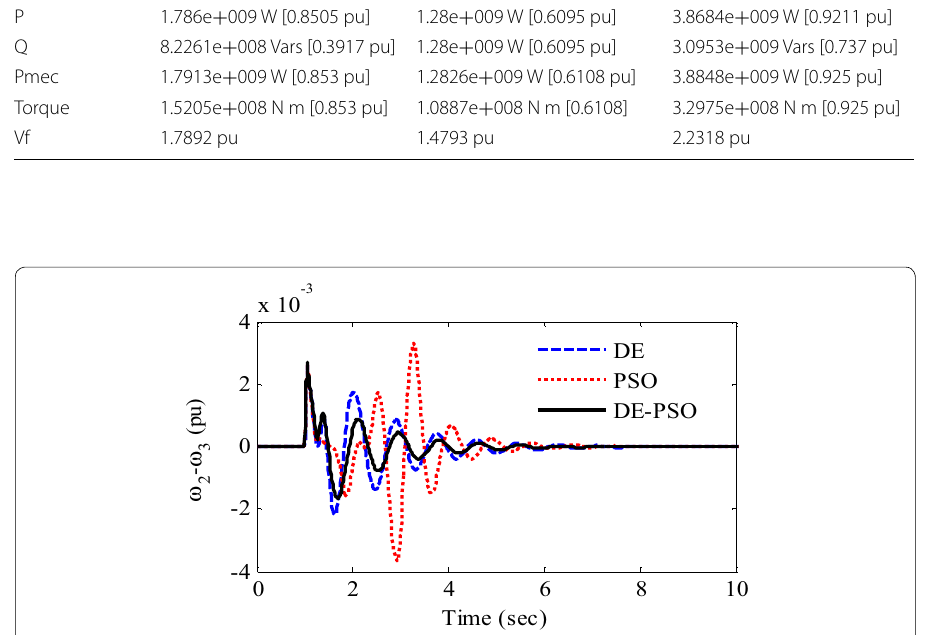
Fig. 2 Inter-area mode